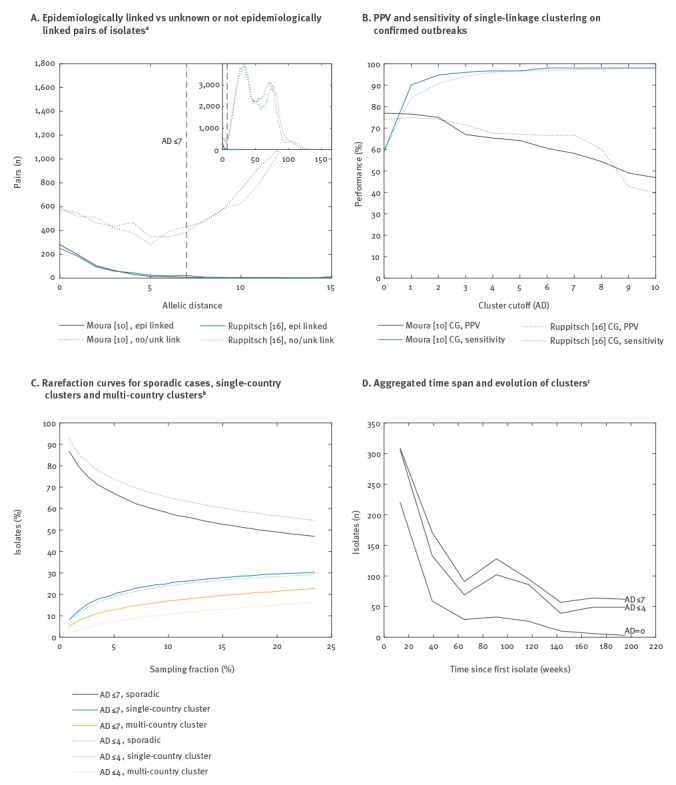
Concordance between cgMLST and epidemiological results for (A) Epidemiologically linked vs unknown or not epidemiologically linked pairs of isolatesa, (B) Positive predictive value and sensitivity of single-linkage clustering on confirmed outbreaks, (C) Rarefaction curves for sporadic cases, single-country clusters and multi-country clustersb, (D) Aggregated time span and evolution of clustersc; Listeria monocytogenes whole genome sequencing study European Union/European Economic Area, 2010‒2015 (n = 2,664)